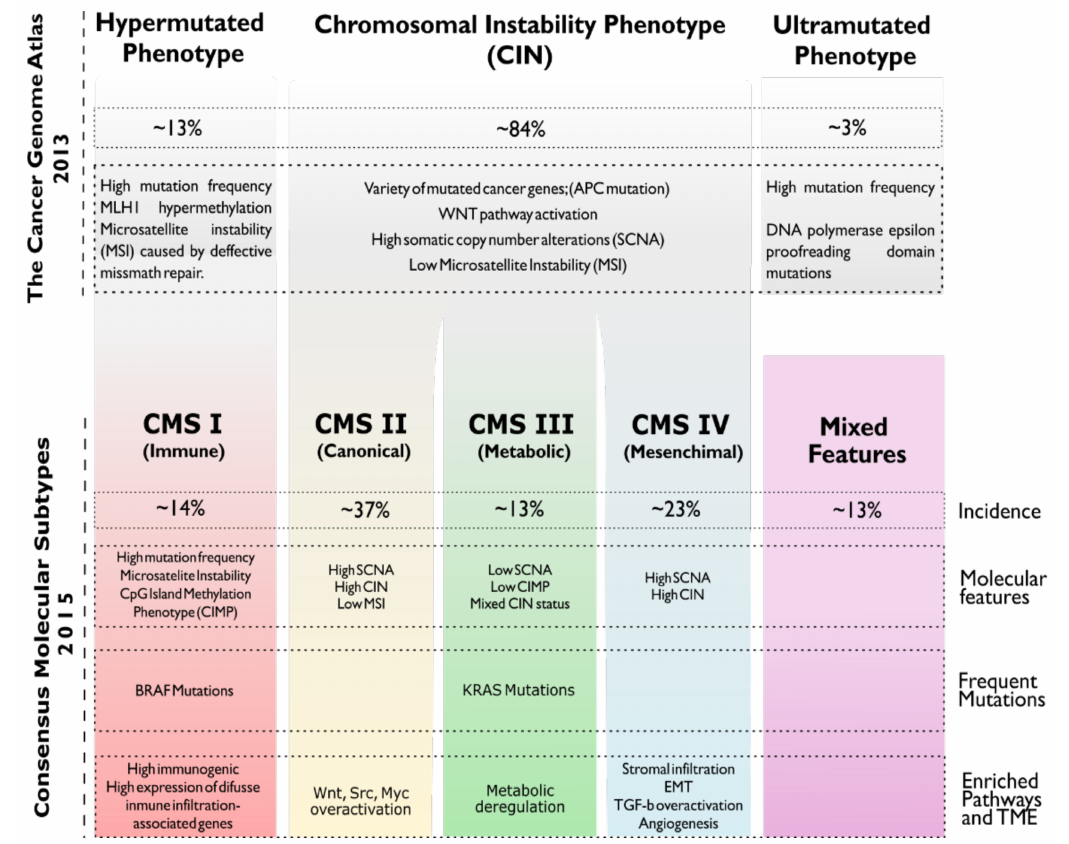
Figure 1. Molecular classifications of CRC tumours. The Cancer Genome Atlas Classification (TCGA) divides CRC tumours into 3 groups according to their mutational status. Meanwhile, Consensus Molecular Subtypes Classification (CMS) proposes to establish 4 groups according to microsatellite instability status (MSI), chromosomal instability (CIN), methylation patterns (CIMP) as well as the most frequently altered pathways, KRAS and BRAF mutational status and tumour microenvironment status